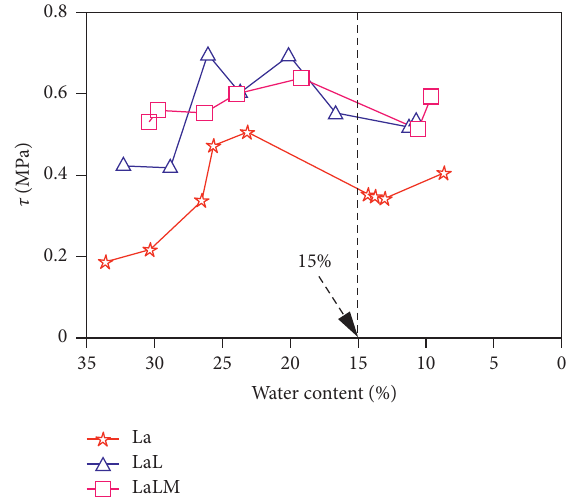
Figure 11: Peaks of direct shear strength vs. moisture